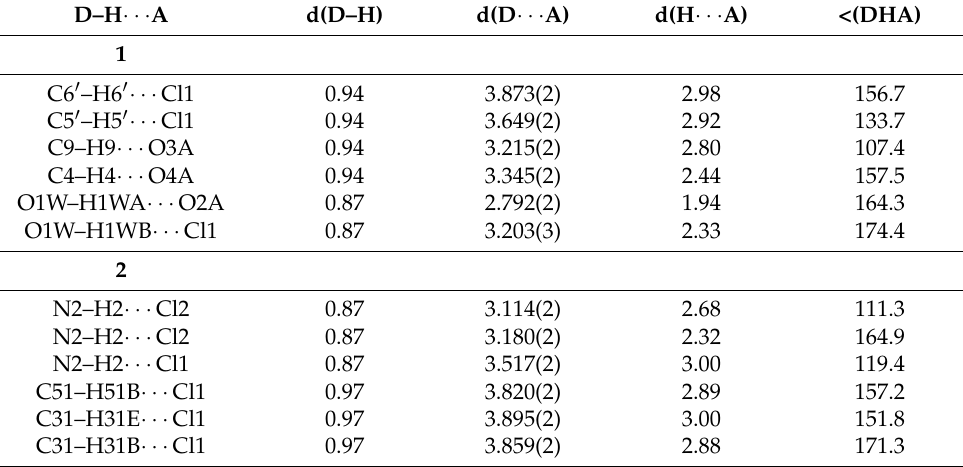
Table 3. Selected hydrogen bond distances (Å) and angles ( ◦ ) for compounds 1 and 2